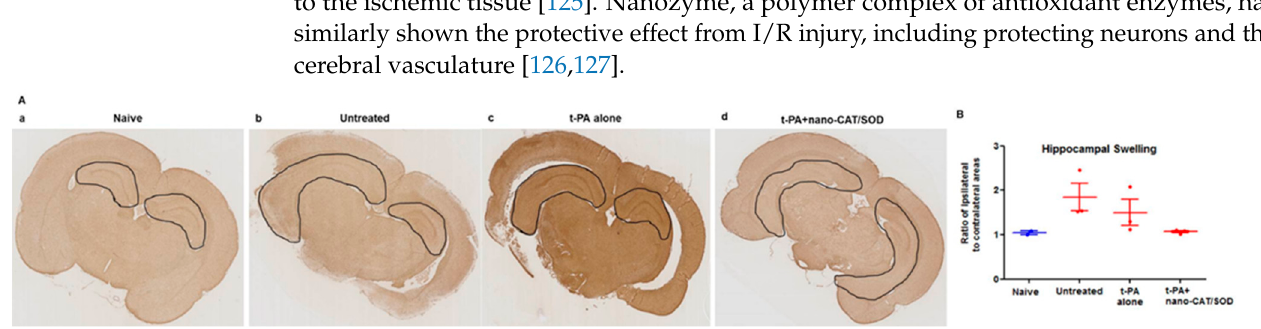
Figure 6. Immunohistochemical analysis of brain sections for hippocampus swelling. Following thromboembolic stroke, animals received different treatments at 3 h, and brains were collected at 48 h post-stroke. Brain sections were stained for GFAP. ( A ) Animals treated with tPA + nano-CAT/SOD show reduced swelling in the hippocampus than untreated and tPA alone treated animals. ( B ) Ratio of the ipsilateral to contralateral hippocampal areas showed reduced hippocampal swelling in tPA + CAT/SOD treated than in other groups. Data as mean ± s.e.m, naïve = 2, other groups = 3 animals in each group. p = 0.06 for untreated vs. tPA + nano-CAT/SOD treated; p = 0.13 for tPA alone vs. tPA + nano-CAT/SOD treated. Reproduced with permission from [122], copyright 2016 Elsevier.